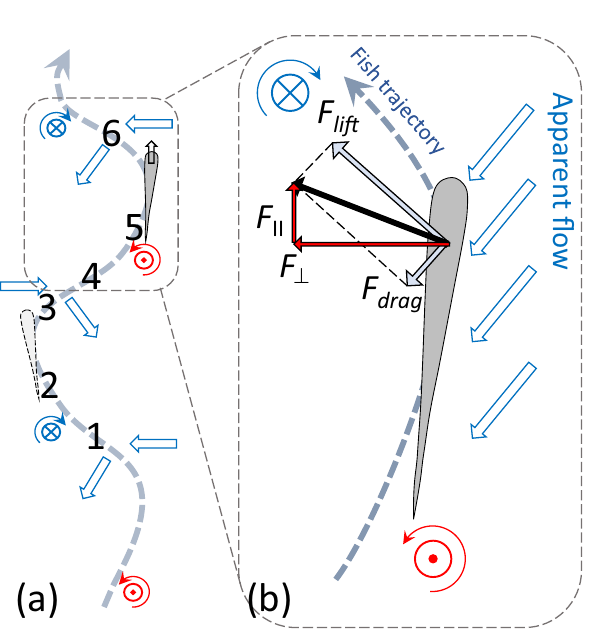
Figure 6. Forces acting on the fish in the flow composed of the uniform component and the component added by vortices. The vector sum of lift and drag forces has a positive streamwise component assisting fish propulsion. The cross-stream component of the hydrodynamic force leads to fish following an undulatory trajectory with the acceleration shown in Fig.